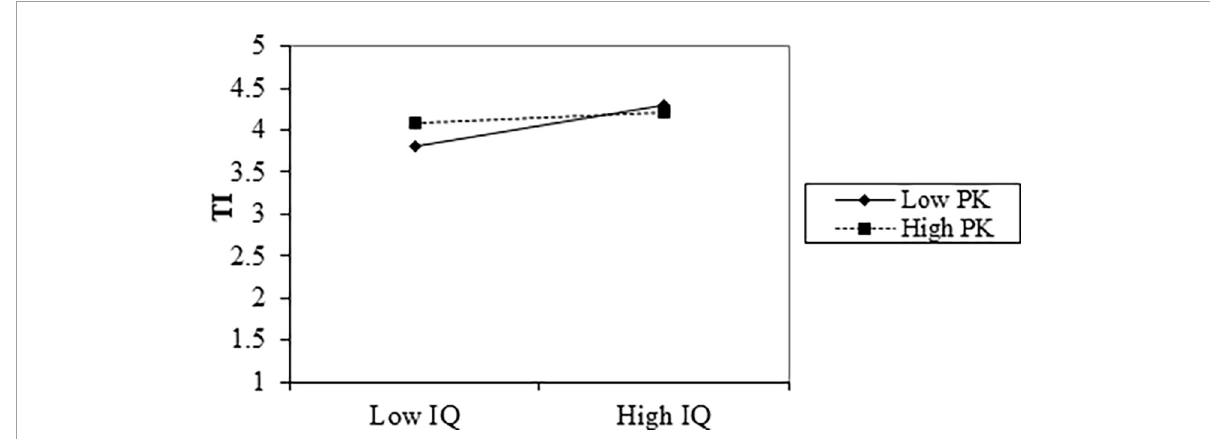
FIGURE2 Interaction of information quality (IQ) and prior knowledge (PK) on travel intention (TI).